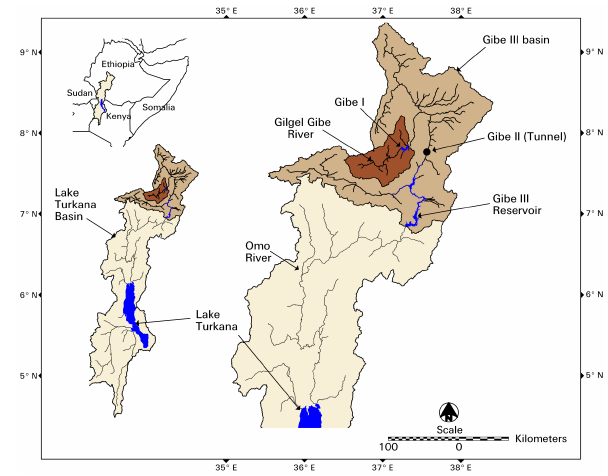
Fig. 1. Study area showing Lake Turkana and its watershed; location of Gibe dams on the Omo River, Ethiopia, are also